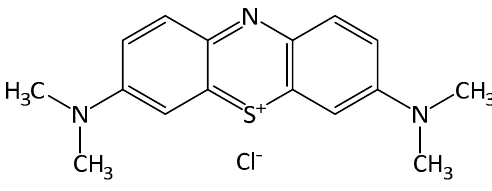
Figure 1. Structure of methylene blue dye.